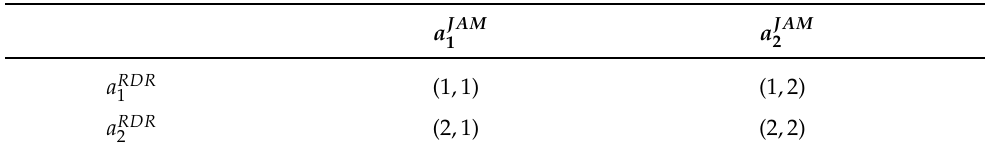
Table 3. Radar and jammer matrix game example.